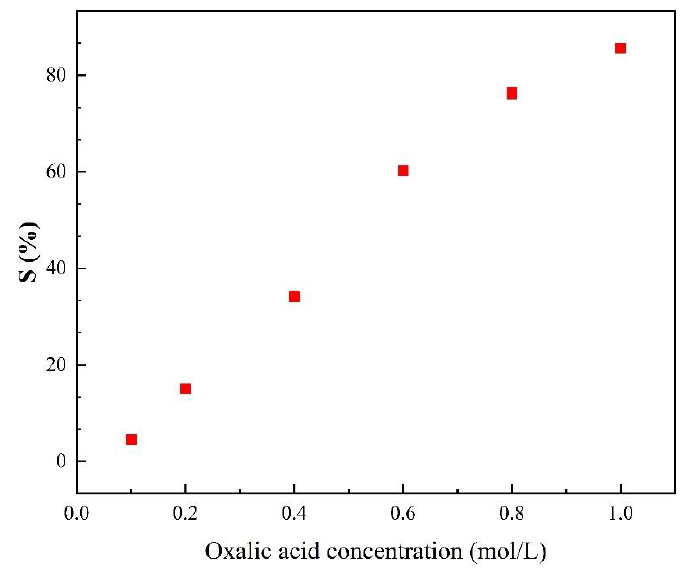
Figure 11. Effects of oxalic acid concentration on the stripping under the conditions: stripping time = 40 min, stripping temperature = 313 K, and phase ratio = 1:1.